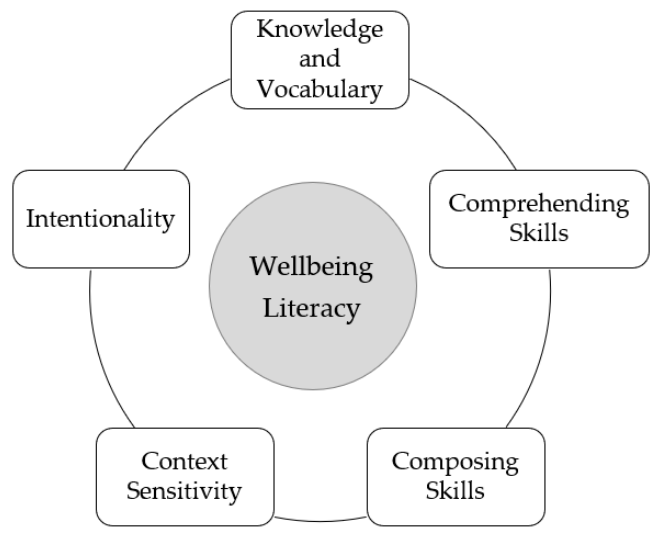
Figure 2. The five components interact to create wellbeing literacy.